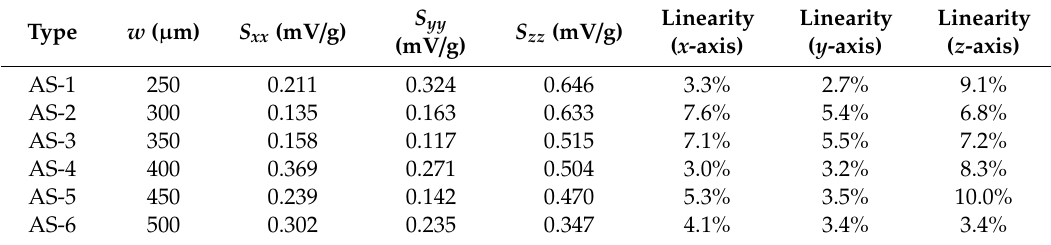
Table 3. The sensitivities of the proposed sensor with di ff erent widths of intermediate double beams.